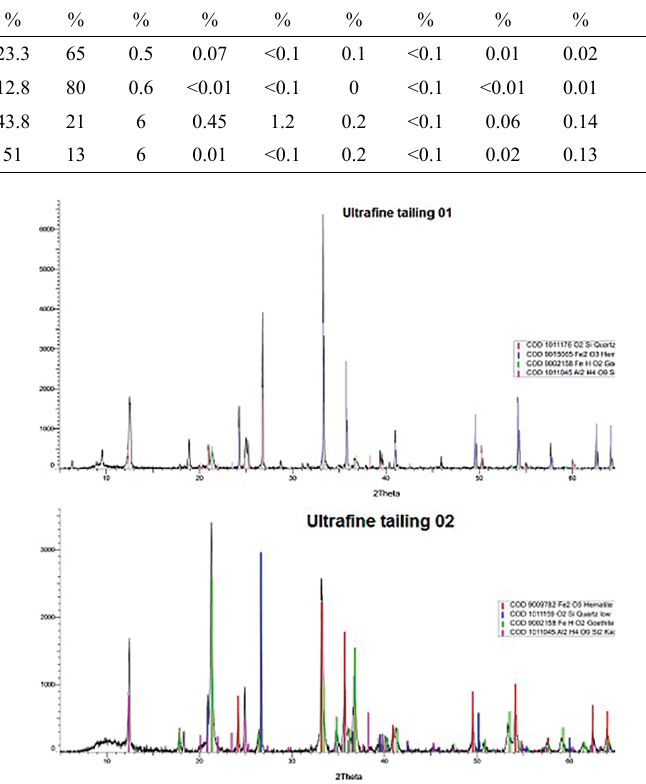
Figure 3. X-ray diffraction for the tailings (ultrafine 01 and 02).